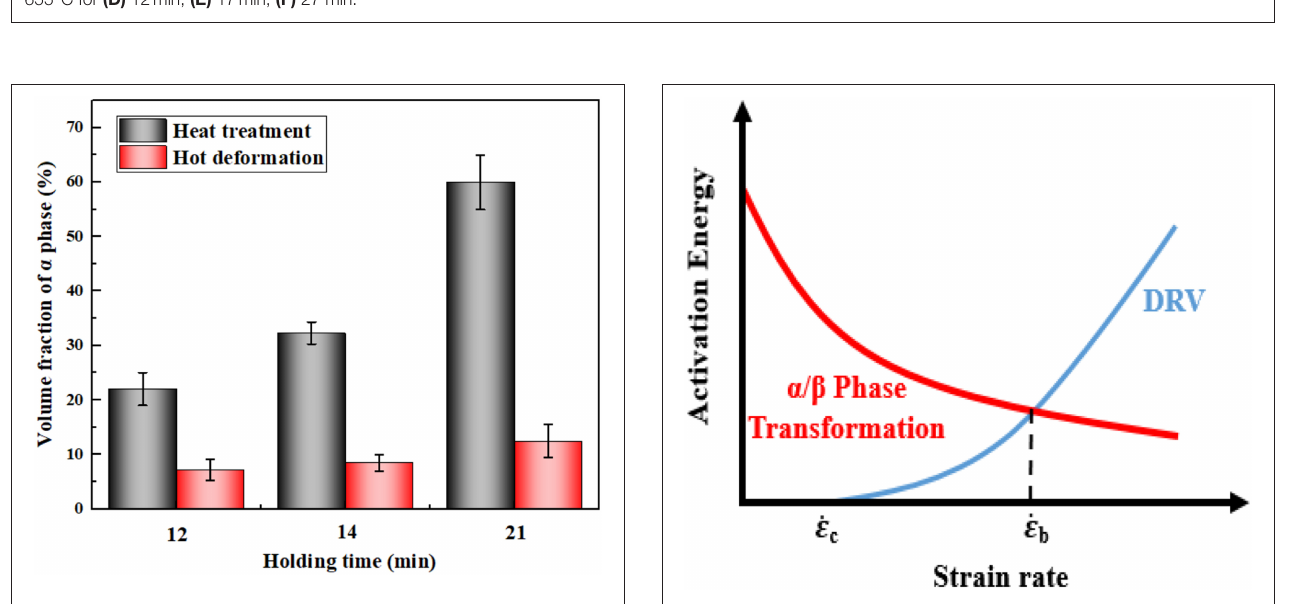
FIGURE 7 | OMs of experimental alloy aged at 655 ◦ C for (A) 12min, (B) 17min, (C) 27min; and SEM images of the α precipitation phase at the grain boundary at 655 ◦ C for (D) 12min, (E) 17min, (F) 27 min.